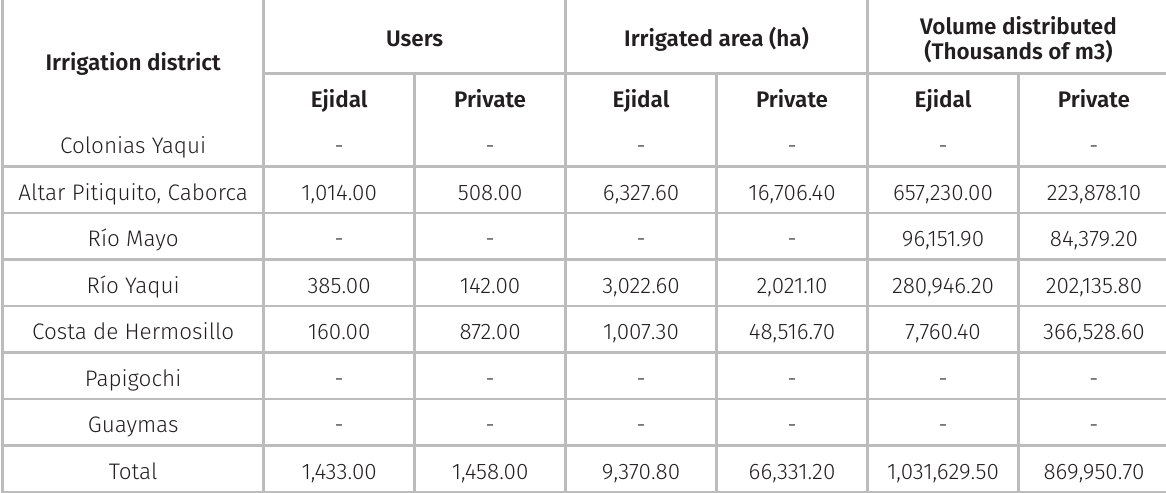
Table III. Physical irrigated surfaces and volumes distributed by type of use and tenure in the irrigation districts of the Northwest basin organisation (pumping-wells).